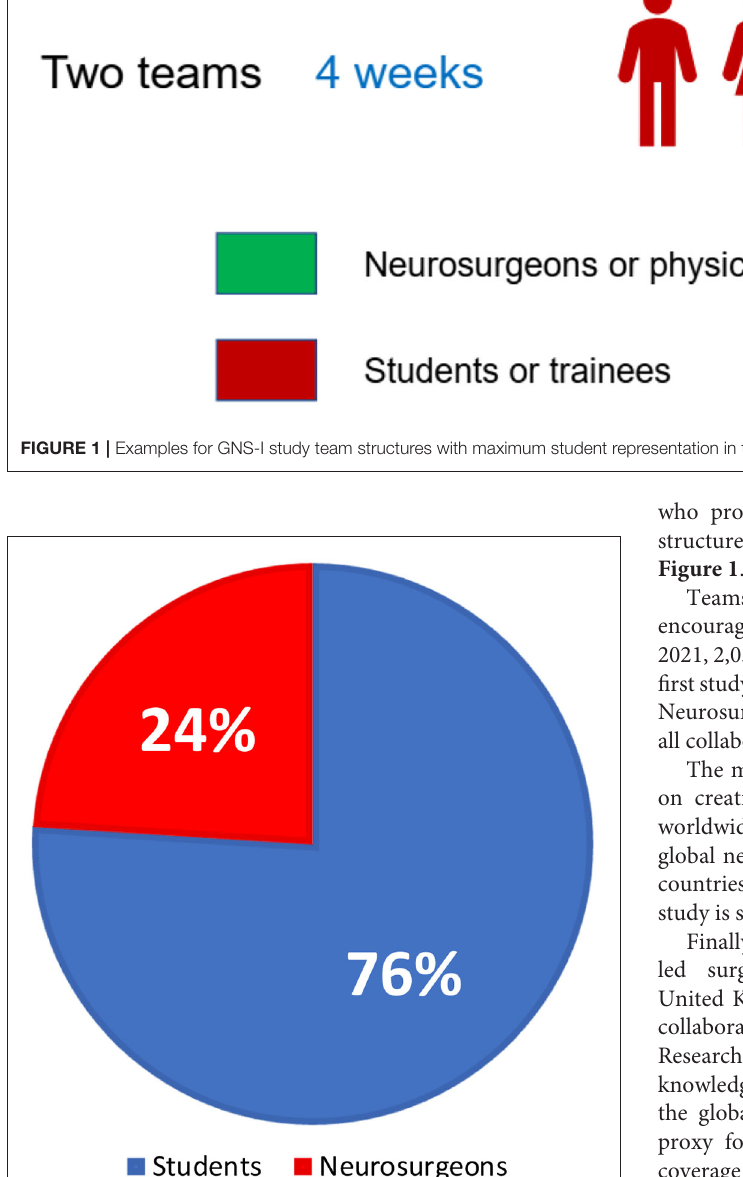
FIGURE 2 | A pie chart of the representation of medical students among all the GNS-I study collaborators.